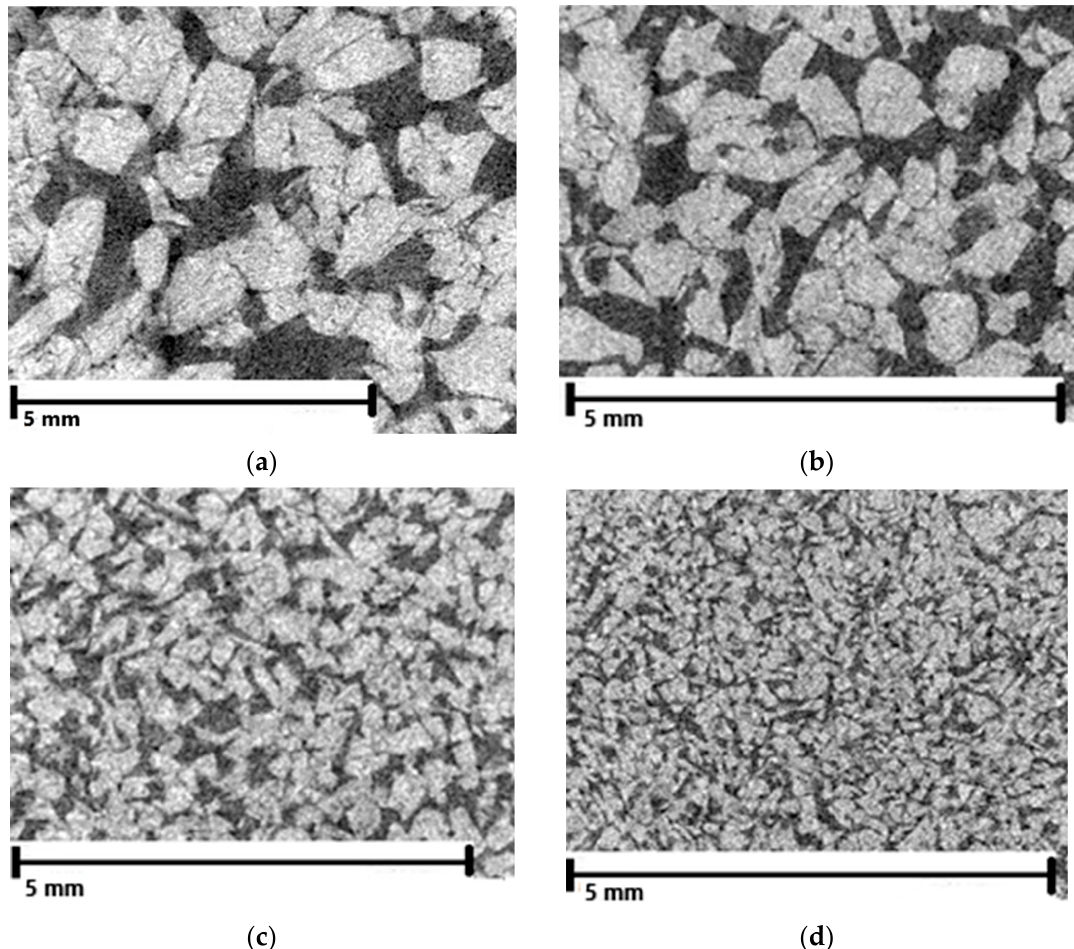
Figure 6. X-ray tomography images for preforms with similar porosity and different pore sizes designated as ( a ) Al 2 O 3 _1, ( b ) Al 2 O 3 _2, ( c ) Al 2 O 3 _3, and ( d ) Al 2 O 3 _4, respectively.